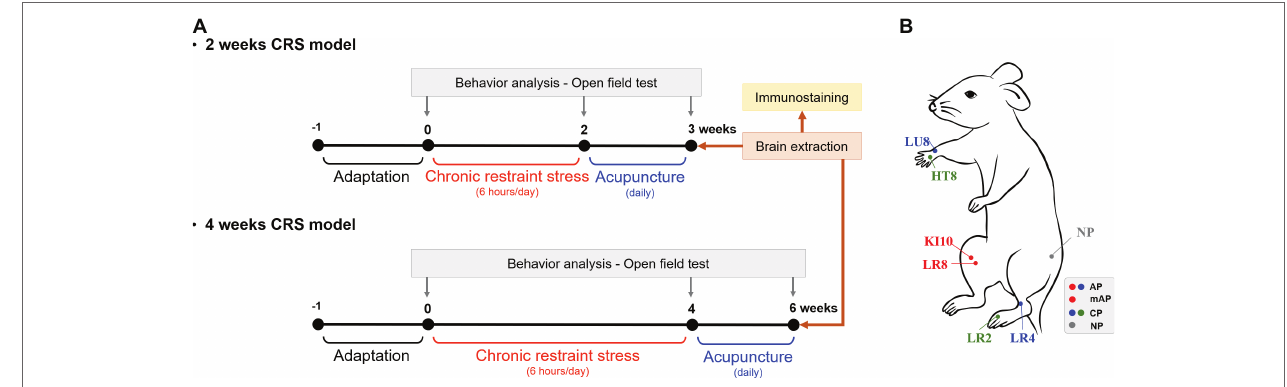
FIGURE 1 | Experimental schedule and acupuncture treatment. (A) Two or 4 weeks of chronic restraint stress (CRS) was used to induce depressive-like behavior. Mice were treated with acupuncture for 7 or 14 consecutive days, respectively, and the open field test was performed to observe behavior patterns. (B) Location of the acupuncture points used in this study. AP, KI10·LR8·LU8·LR4; mAP, KI10·LR8; CP, LU8·LR4·HT8·LR2; NP, non-acupoints on the